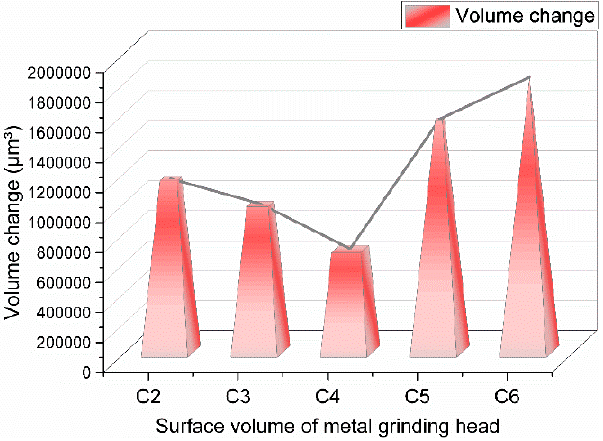
Figure 13. Metal wear volume without spraying high-temperature ethanol–water vapor mixture.